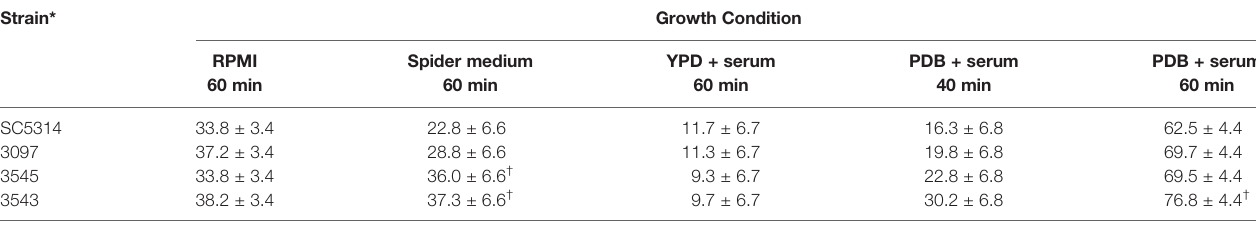
TABLE 2 | Percent germ tubes in cultures of control strain SC5314 and the D pir/ D pir mutants. Strain*